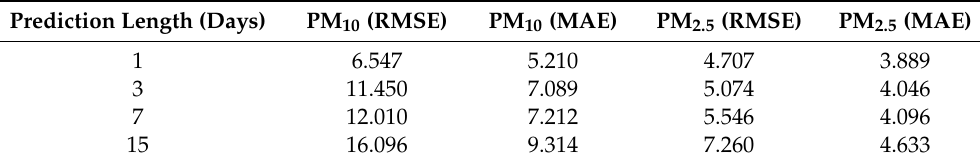
Table 7. Fifteen-day predicted results at one station